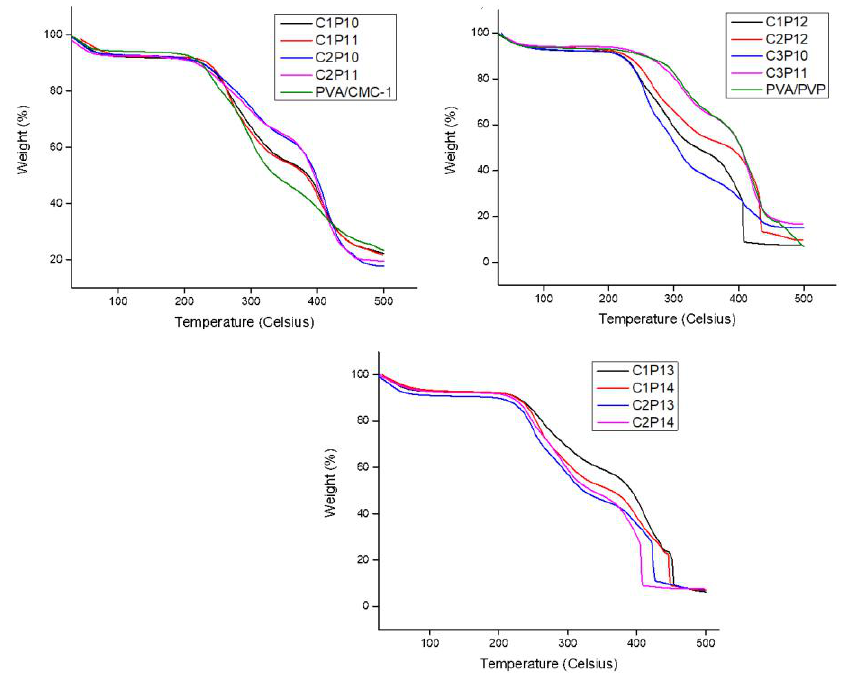
Figure 5. Thermogravimetric analysis (TGA) plot of PVA/PVP, PVA/CMC, and tri-component PVA/PVP/CMC (C1P10 to C3P12) nanofibers: Effect of variation in weight ratios of PVP and CMC on thermal properties of nanofibrous mats .